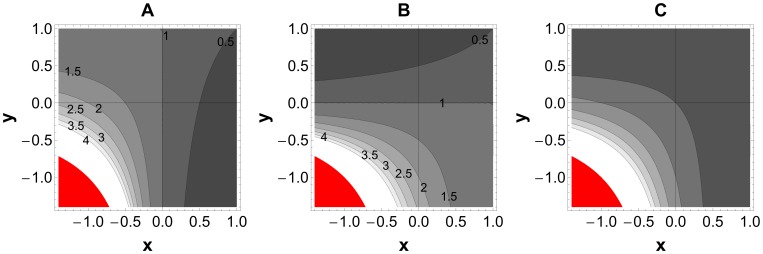
Effect of various mixes of facilitation and competition on the within-host dynamics of coinfecting species. A,Equilibrium densities of parasite A (A*). B, Equilibrium densities of parasite B (B*). C, Virulence such that V = aA*+bB*. The red region represents the region where all equilibria are destabilized (i.e. xy>z, x<0 and y<0). Darker regions indicate lower values. The values on the contour lines indicate the relative densities of parasite at equilibrium. The line x = 0 defines the density of parasite A alone, and y = 0 defines the density of parasite B alone. The parameter values used are a = b = z = 1.